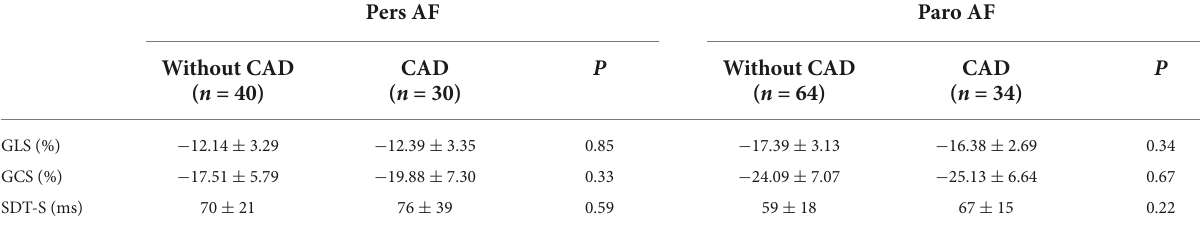
Without CAD ( n = 64)